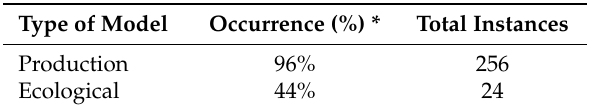
Table 5. Type of model in